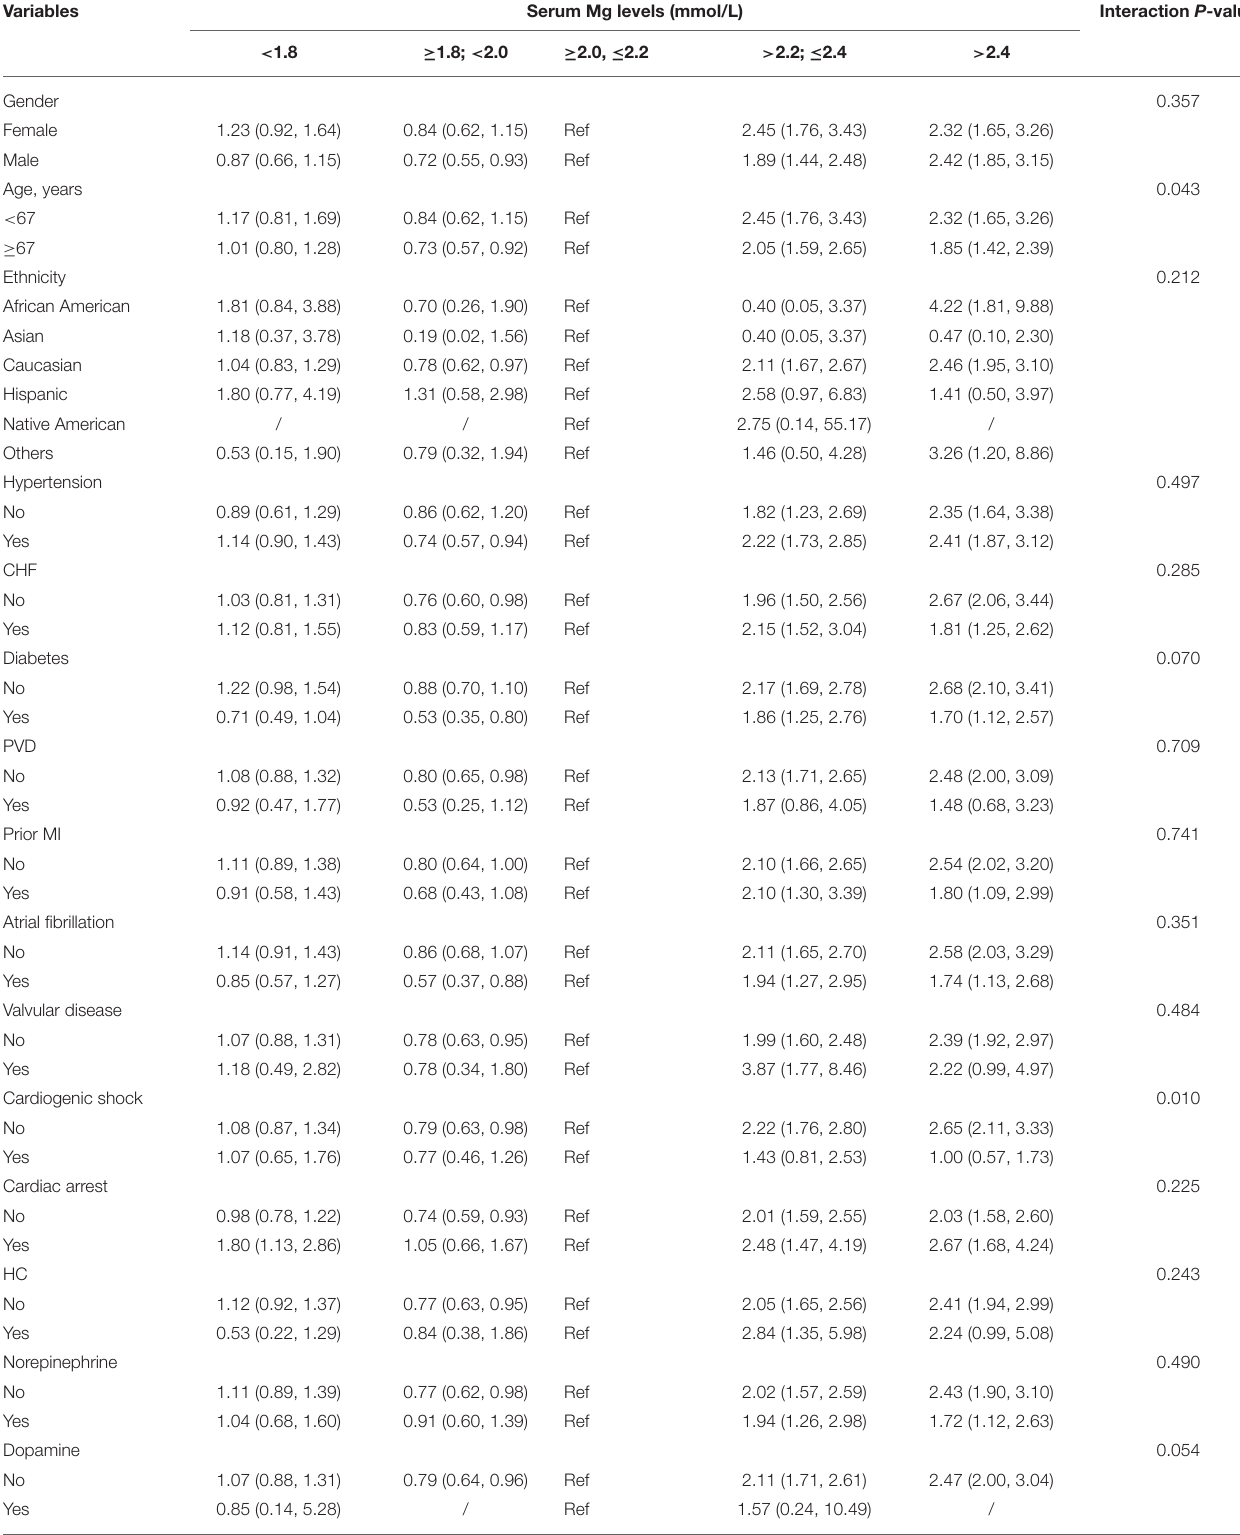
TABLE 4 | Subgroup analyses of the associations between serum magnesium levels and in-hospital mortality in logistic regression model. Variables Serum Mg levels (mmol/L) Interaction P